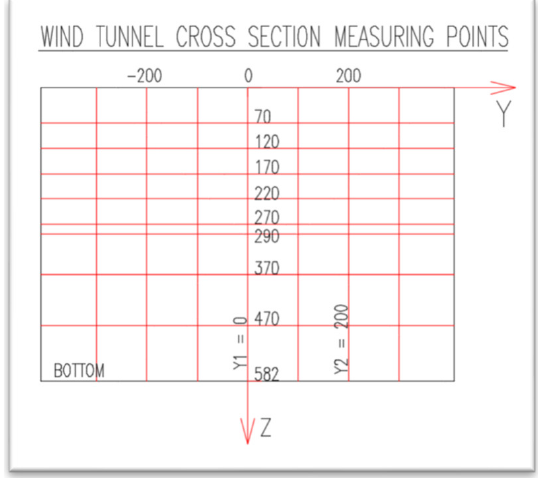
Figure 6. Measuring points. Cross section of the wind tunnel.